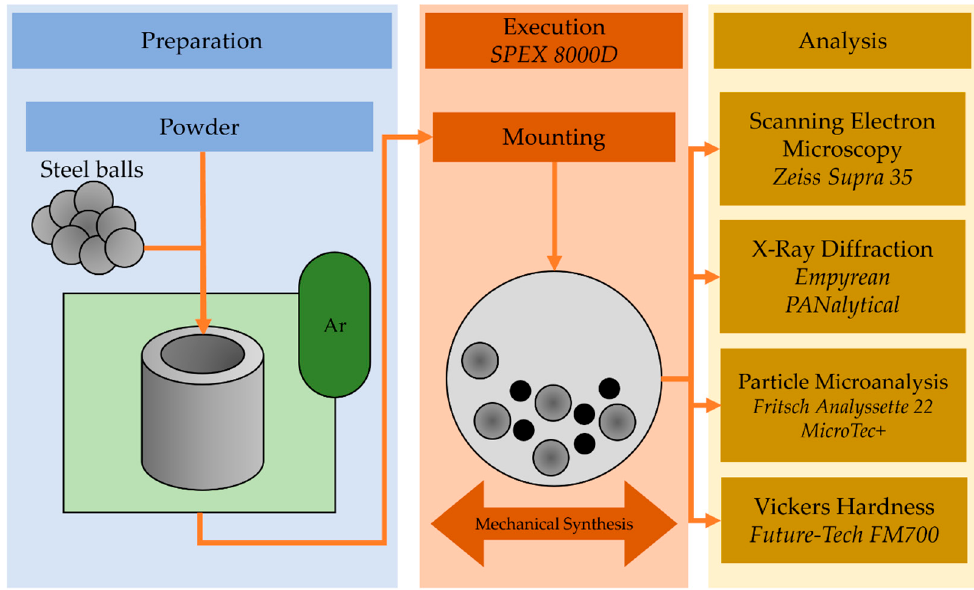
Figure 1. Schematical representation of the experimental process.